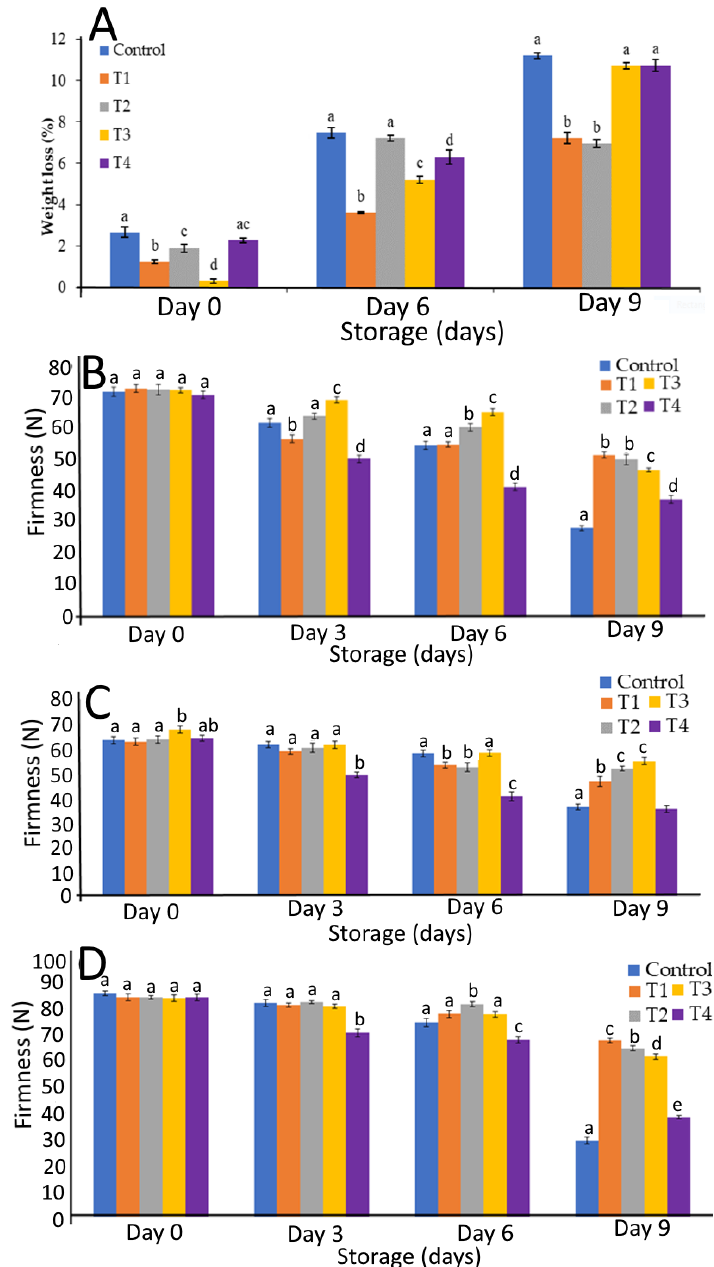
Figure 1. Weight loss ( A ) and firmness of ( B ) whole guava fruits, ( C ) guava flesh, and ( D ) guava skin at different maturity stages of guava fruits. Different lowercase letters (a–e) within the same group represent significant differences based on Tukey’s honest significance test ( p < 0.05). For sample codes, refer to Table 2.